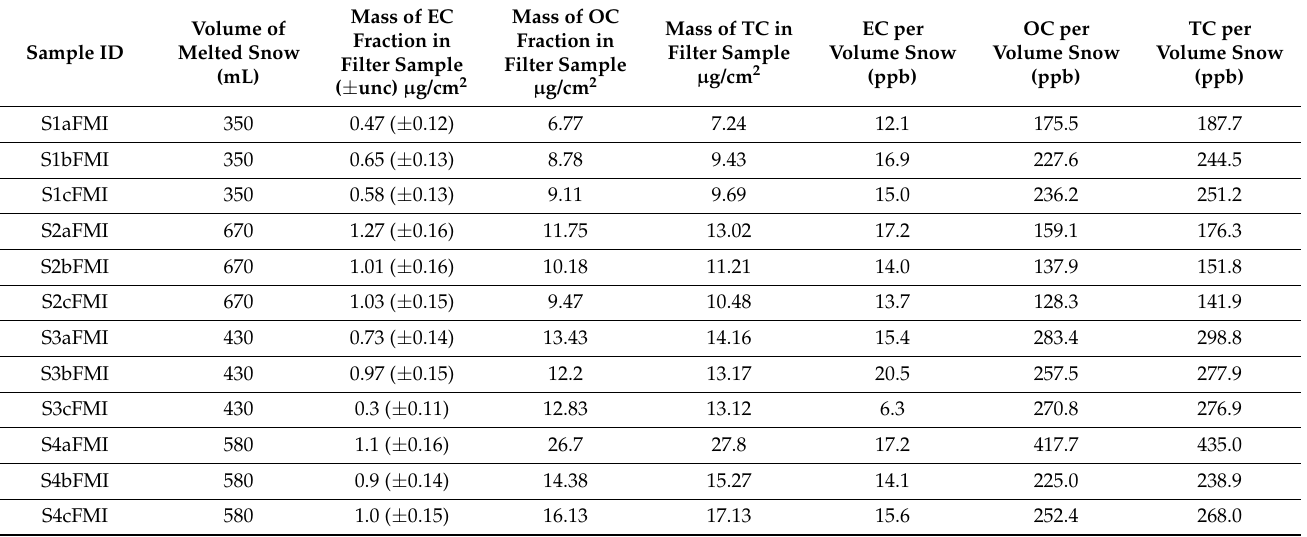
Table 3. The EC, OC, and TC results of Finnish Meteorological Institute. The analysis uncertainty is ± 0.2 µ gC (+5% relative error for higher loaded